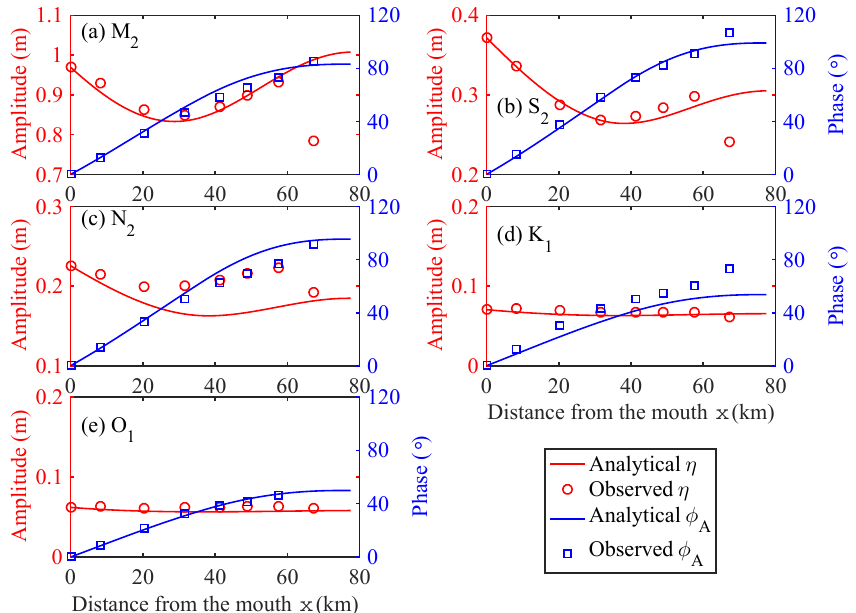
Figure 6. Tidal constituents (a) M 2 , (b) S 2 , (c) N 2 , (d) K 1 and (e) O 1 , modeled against observed values of tidal amplitude (m) and phase ( ◦ ) of elevation along the Guadiana estuary.